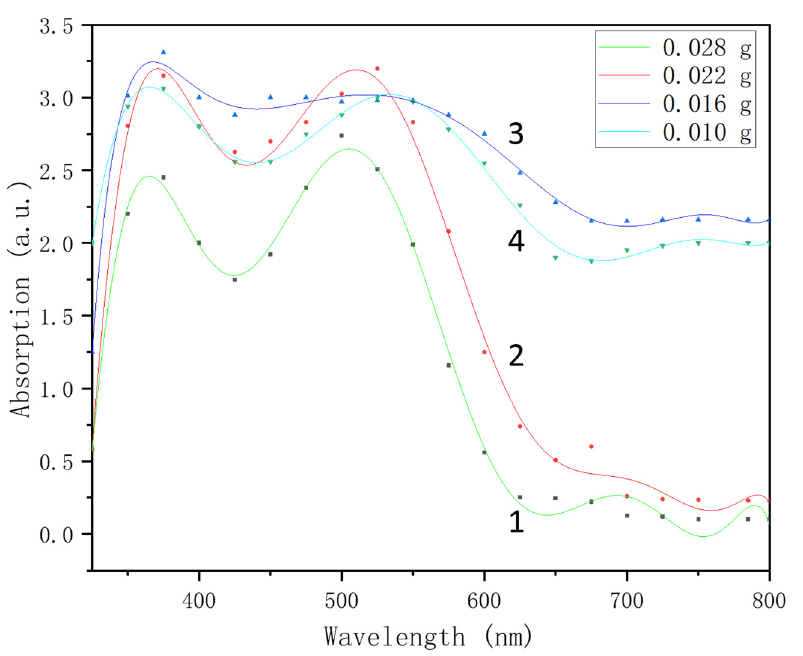
Figure 1. The UV–vis spectra of Au NPs synthesized by various masses of sodium citrate (1) 0.028 g; (2) 0.022 g; (3) 0.016 g; (4) 0.010 g.